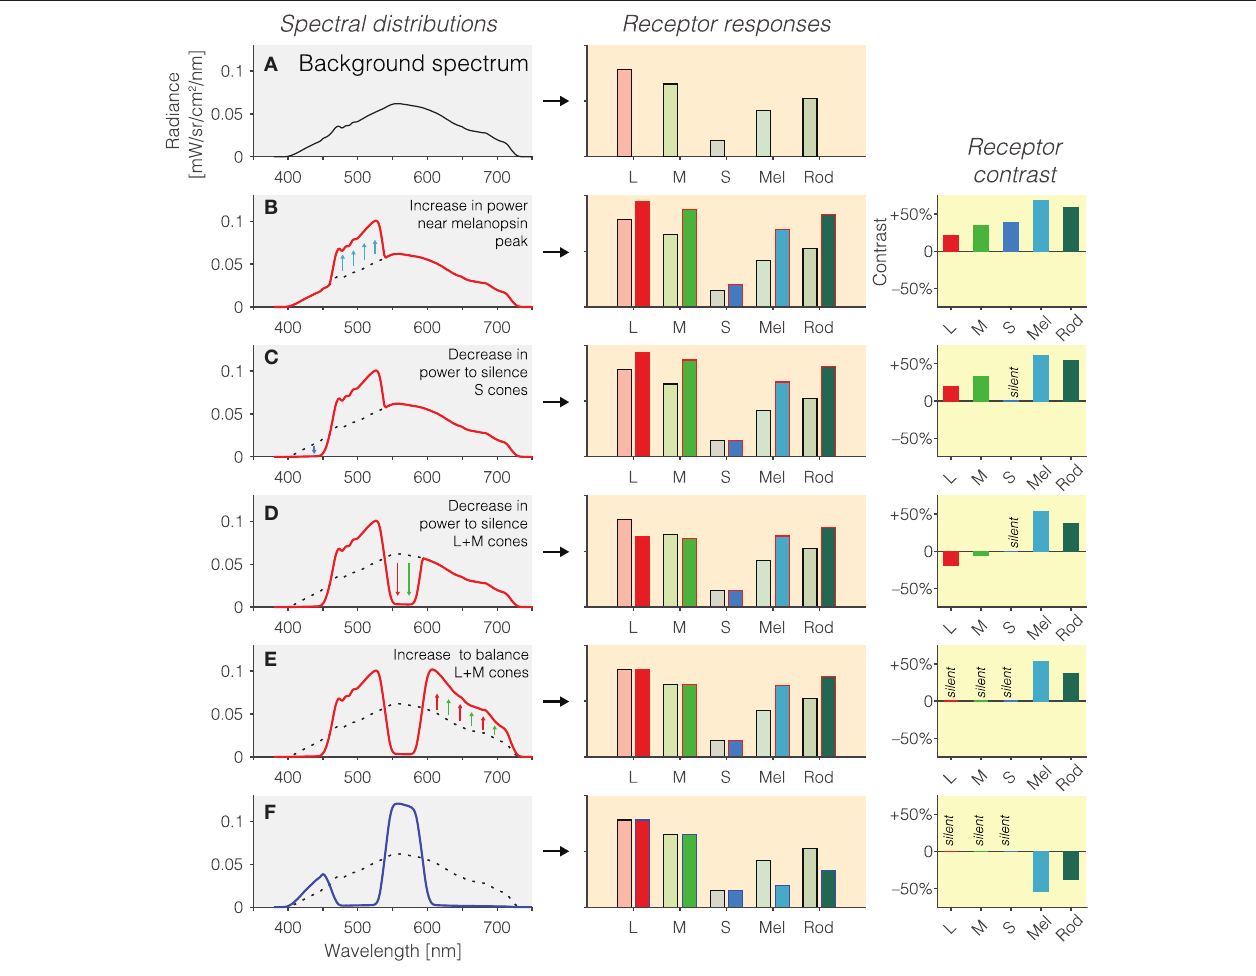
FIGURE 2 | (A) Background spectrum (left panel) to which the observer is light-adapted, eliciting a pattern of responses in the photoreceptors (right panel). (B) Increase in emitted light near the melanopsin peak relative to the background spectrum (left panel; dashed line = background spectrum, red line = modulation spectrum) leads to an increase in the excitation of all photoreceptors (middle panel), or equivalently, positive contrast on the photoreceptors (right panel). (C) To balance the excitation of the S cones, a decrease in emitted short-wavelength light (left panel) leads to silencing of the S cones (middle panel), or equivalently, zero contrast on the S cones (right panel). (D) To balance the excitation of the L and M cones, a decrease in emitted medium-wavelength light (left panel) leads to a reduction in L and M cone activity (middle panel) but not yet zero contrast on the L and M cones (right panel); indeed, the contrast seen by the L and M cones is now negative. (E) To silence the excitation of the L and M cones, a decrease in emitted long-wavelength light (left panel) leads to balancing of the L and M cones (middle panel), or equivalently, zero contrast on the L and M cones (right panel). The contrast seen by melanopsin is 50%. (F) The modulation spectrum shown in (E) yields positive contrast relative to the background spectrum but the spectrum can also be “mirrored” around the background spectrum, thereby leading to a negative modulation of melanopsin (and rods).